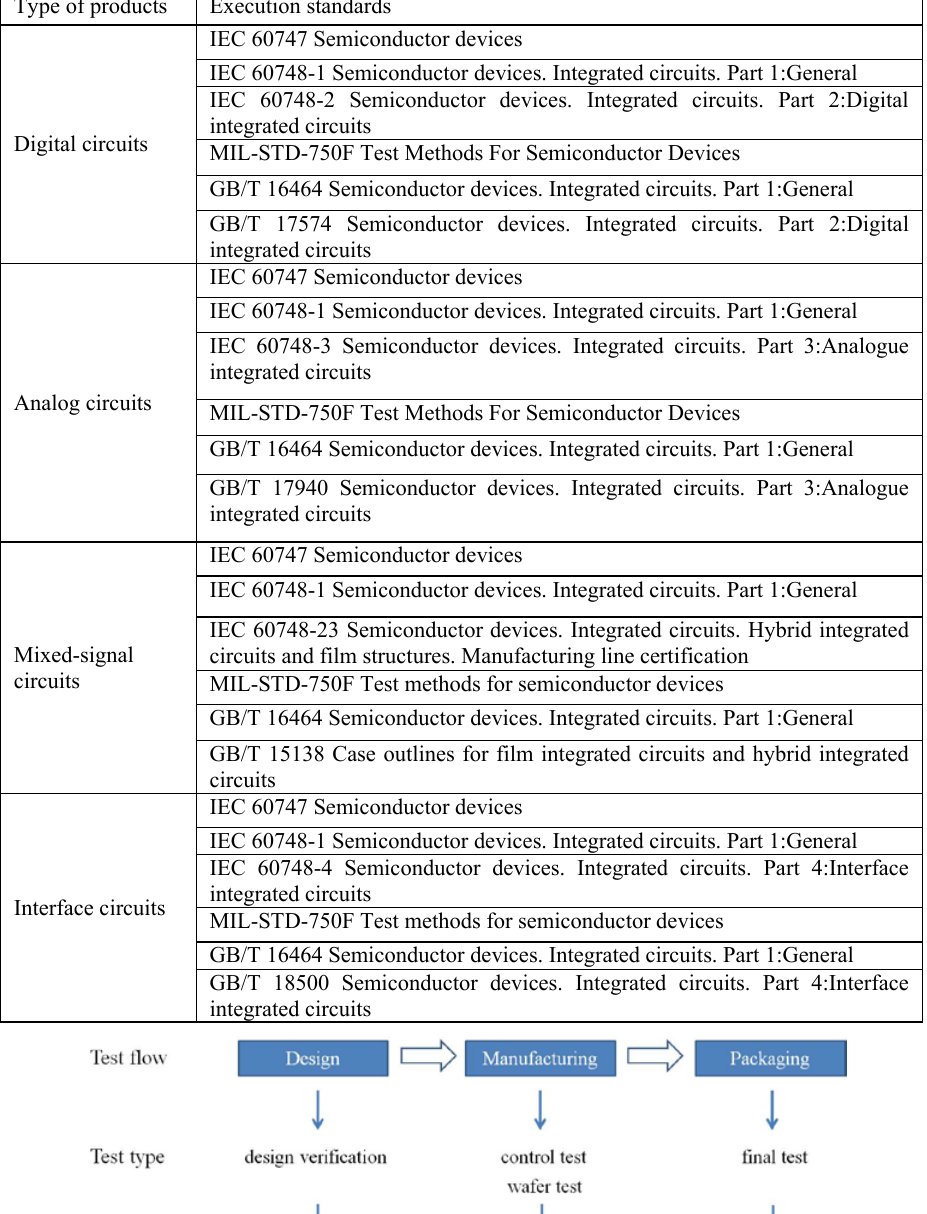
Table 1. The main products and execution standards - classified by signal processing mode. Type of products